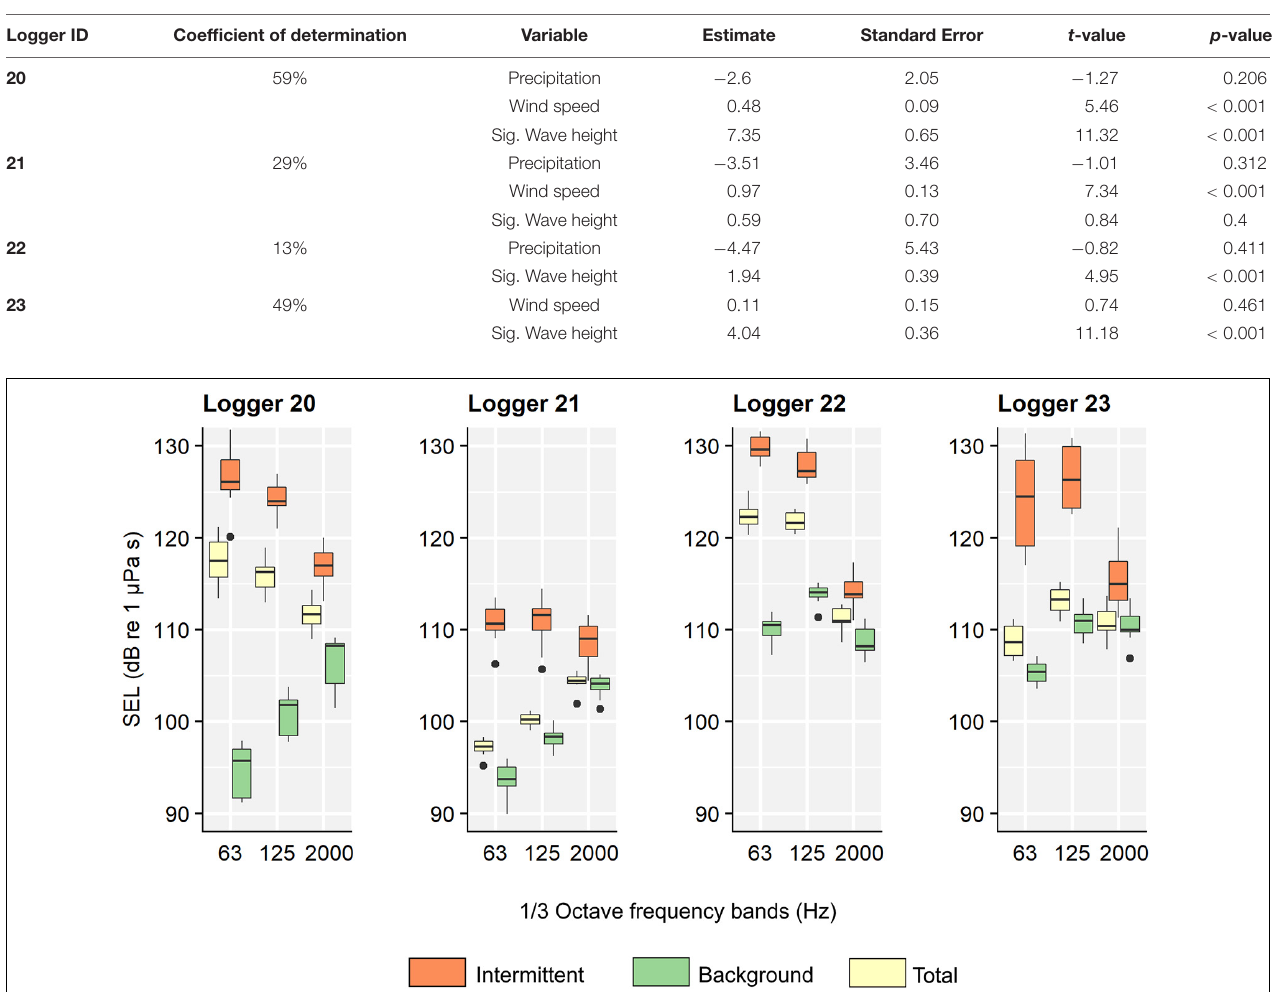
TABLE 4 | The coefficients of multiple regression analysis of all the loggers.